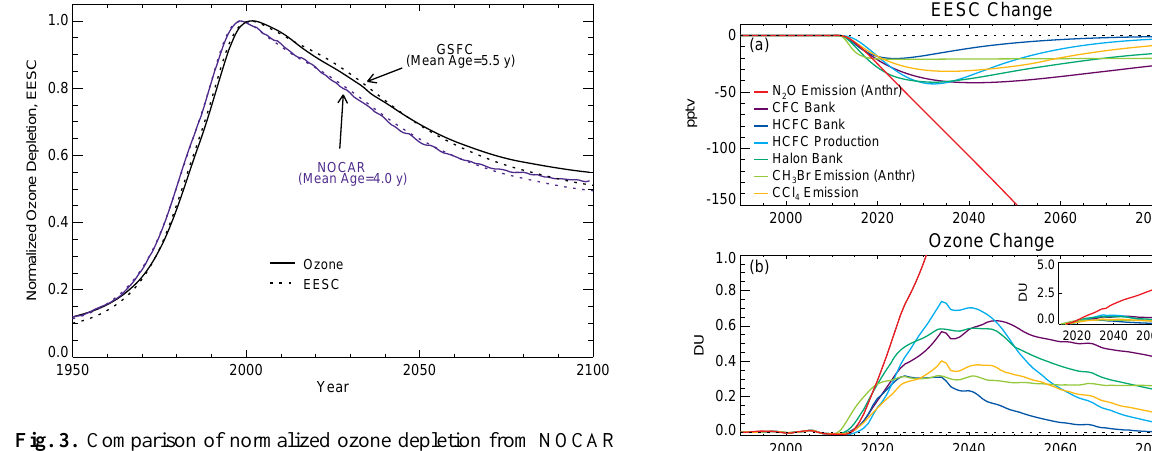
Fig. 3. Comparison of normalized ozone depletion from NOCAR (blue) and GSFC (black) models with EESC (dashed). Ozone de- pletion for each model is normalized to the maximum depletion, and EESC is normalized to its peak value. Age spectra used in the EESC calculations were determined by fitting the normalized EESC curves to the normalized ozone time series using a least-squares ap- proach. Mean ages derived for the EESC fits are shown. Age spec- tra widths were found to be 2.4 and 2.9 years, respectively, for the NOCAR and GSFC calculations. The older characteristic age for the GSFC model is apparent.